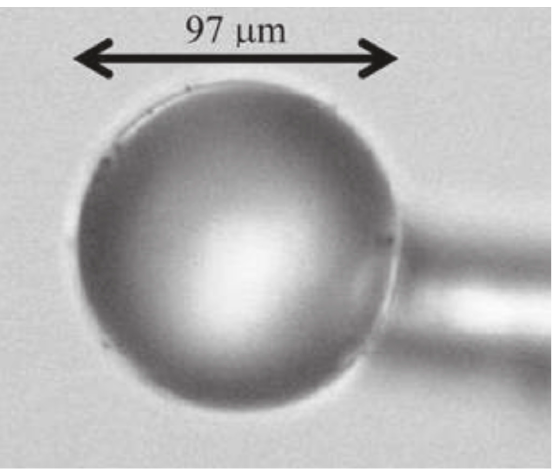
Figure 10. Optical micrograph of a single Er3+-activated silica sphere of about 100 µm diameter stuck onto a tapered silica fi ber by means of a transparent optical component adhesive. Reproduced